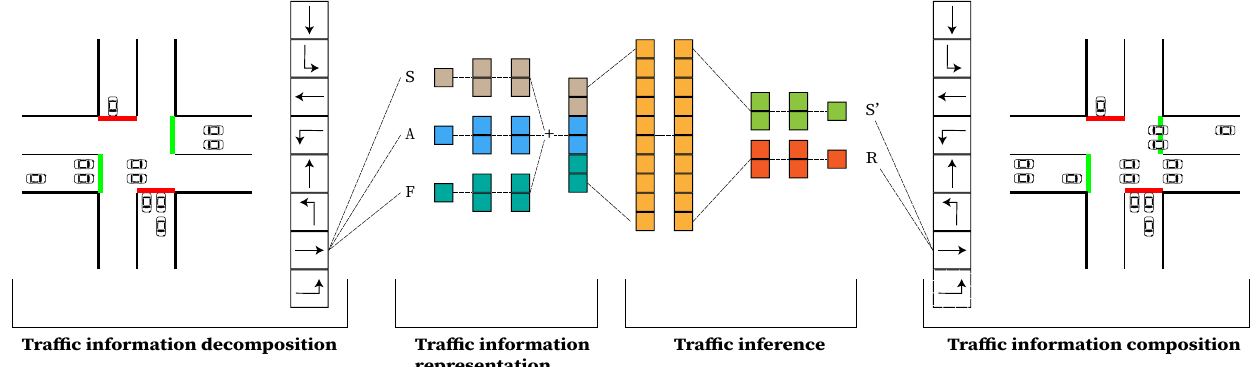
Figure 3. Neural network